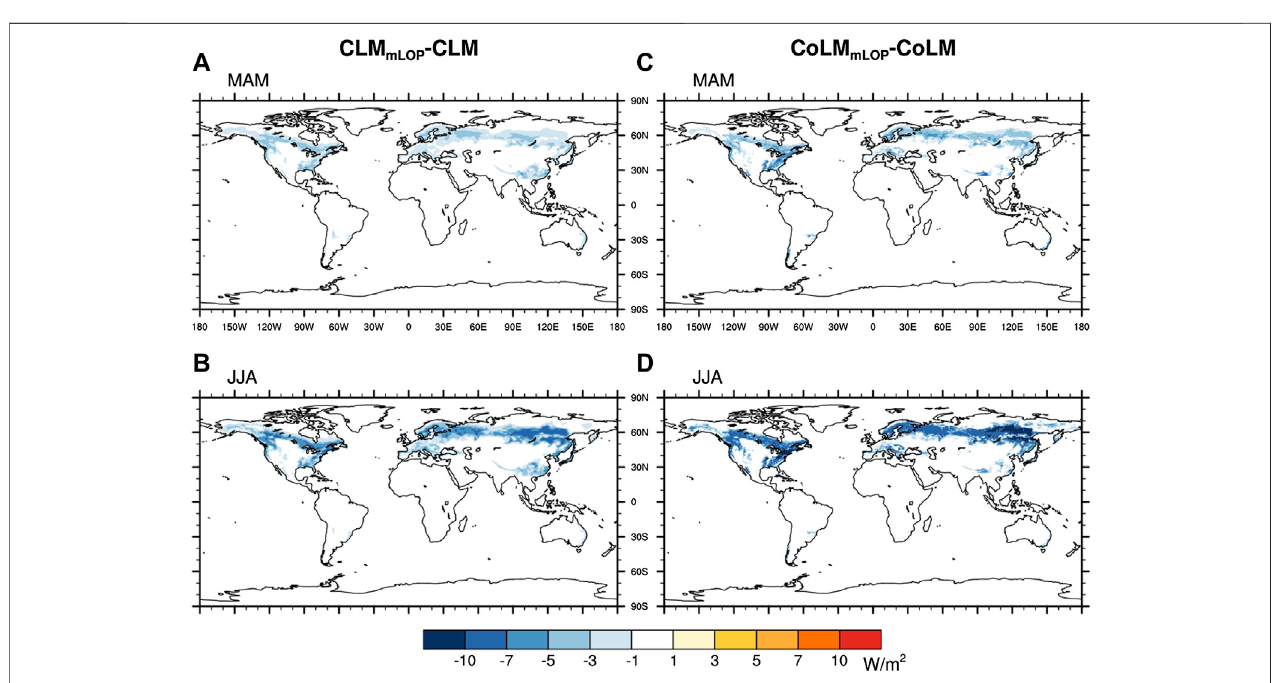
FIGURE 8 | The information is the same as that in Figure 7 but for net